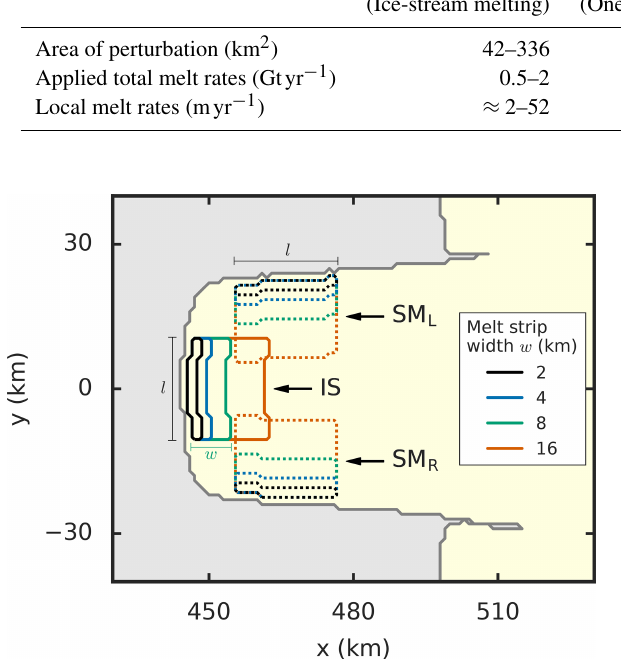
Figure 3. Ice-shelf regions IS, SM L and SM R in which the basal melt perturbations are applied (zoom into grounding-line region). While all perturbation areas have the same length l along the grounding line, their width w is varied in the simulations (col- ored contours). The steady-state grounding line is represented by the dark gray contour, the ice sheet is colored light gray, the floating ice shelf is colored yellow. Continuous and dotted contours are used for better distinguishability between the central and lateral melt re-